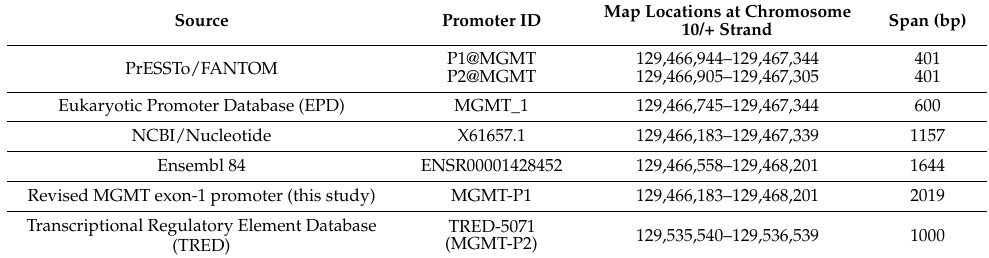
Table 1. Five alternative overlapping promoters were identified at the 5’-side of MGMT exon-1. The revised version of the 5’-side MGMT exon-1 promoter ( MGMT-P1 ) included the five sequences of overlapping alternative promoters. One predicted promoter was located at the 5’-side of MGMT exon-2 ( MGMT-P2